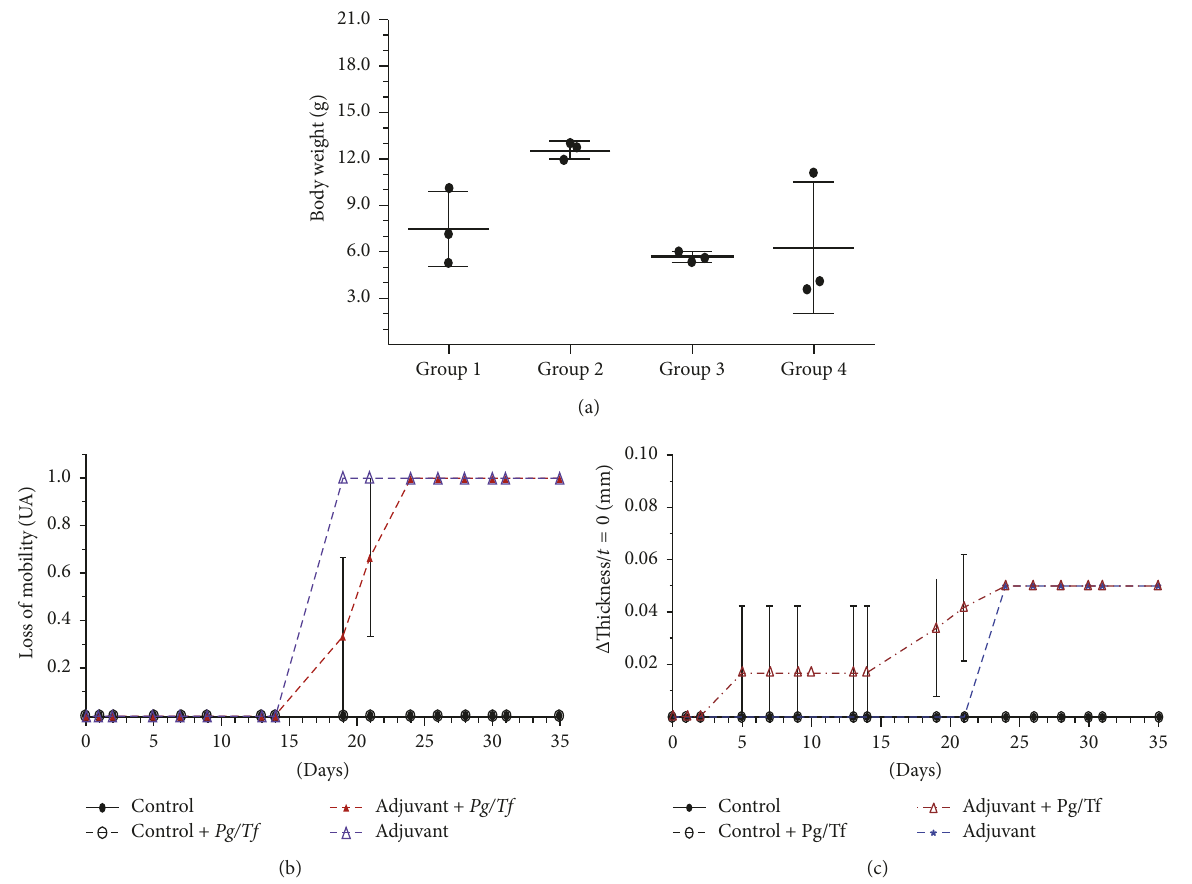
Figure 1: (a) Effect of treatment with CFA and bacterial inoculation on change in body weight of experimental animals. The results of 3 animals per group, the mean and standard deviation are shown. To determine the change in body weight of each animal, the difference was obtained between the weight at the start of the experiment (day 0) and at the end of the experiment (day 35). The evaluation was performed based on a dichotomous criterion: normal mobility and decreased mobility. With the Kruskal-Wallis test, the difference between the groups did not reach statistical significance ( 𝑝 = 0.0784 ), although the change in body weight of Group 2 seemed to be greater in relation to the other groups. (b) Effect of treatment with CFA and bacterial inoculation on loss of mobility. Results of 3 animals per group; the mean and standard deviation are shown. To determine the change of mobility of each animal, each evaluation was performed based on a dichotomous criterion: normal mobility and reduced mobility. Solid black line, sham (Group 1); black dashed line, sham + Pg/Tf (Group 2); blue dashed line, CFA + Pg/Tf (Group 3); red dashed line, CFA alone (Group 4). A loss of mobility was observed from day 19 in the CFA group, while the loss of mobility was complete in the CFA + Pg/Tf group starting on day 24 of the study. (c) Effect of treatment with CFA and bacterial inoculation on hind leg thickness. Results correspond to the mean and standard deviation of the two hind limbs of 3 animals per group. The change in thickness ( Δ Thickness) was determined based on the difference between the initial thickness of the foot pad and thickness during the different study times. Solid black line, sham (Group 1); black dashed line, sham + Pg/Tf (Group 2); blue dashed line, CFA + Pg/Tf (Group 3); red dashed line, CFA alone (Group 4). The group treated with CFA without Pg/Tf showed an increase in thickness after day 19. The group treated with CFA and with Pg/Tf showed a delayed increase (day